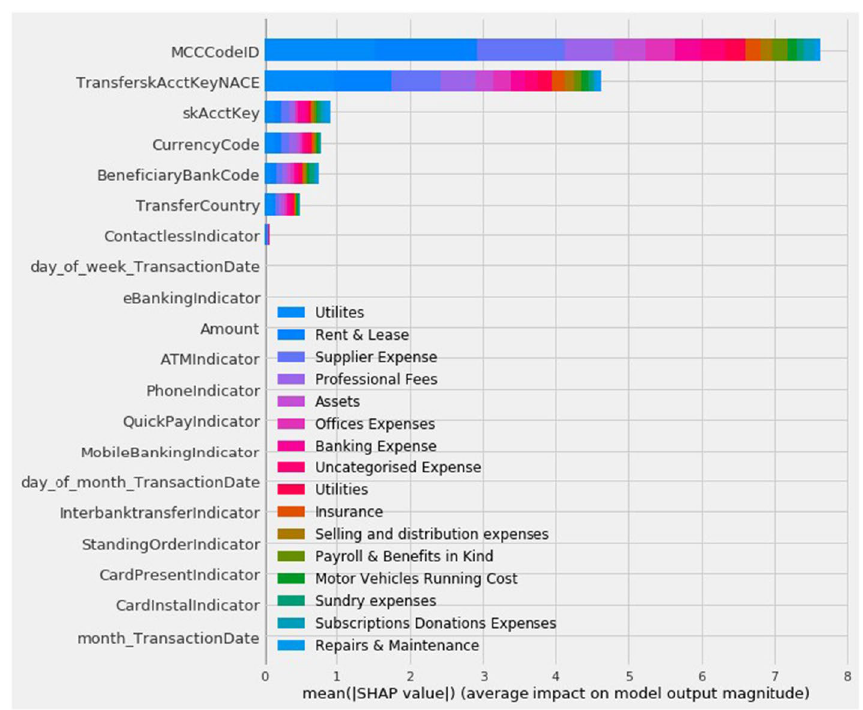
Fig. 8 SHAP values indicating feature importance of Cathbost transaction categorization